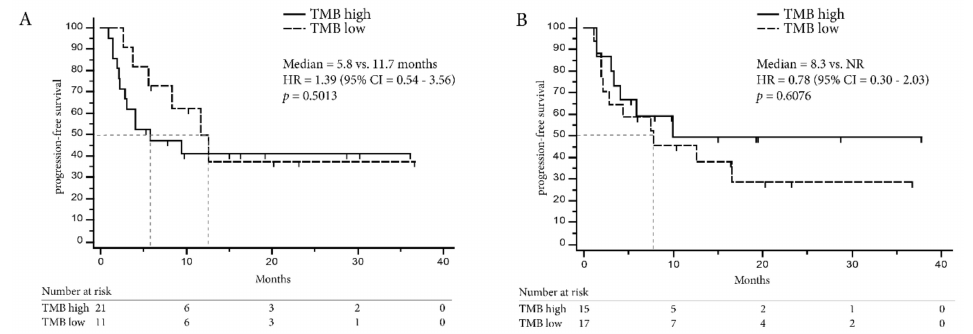
Figure 6. Progression-free survival according to TMB in melanoma patients. ( A ) Progression-free survival (PFS) is computed for the melanoma dataset using OTML and ( B ) FO NR = median PFS was not